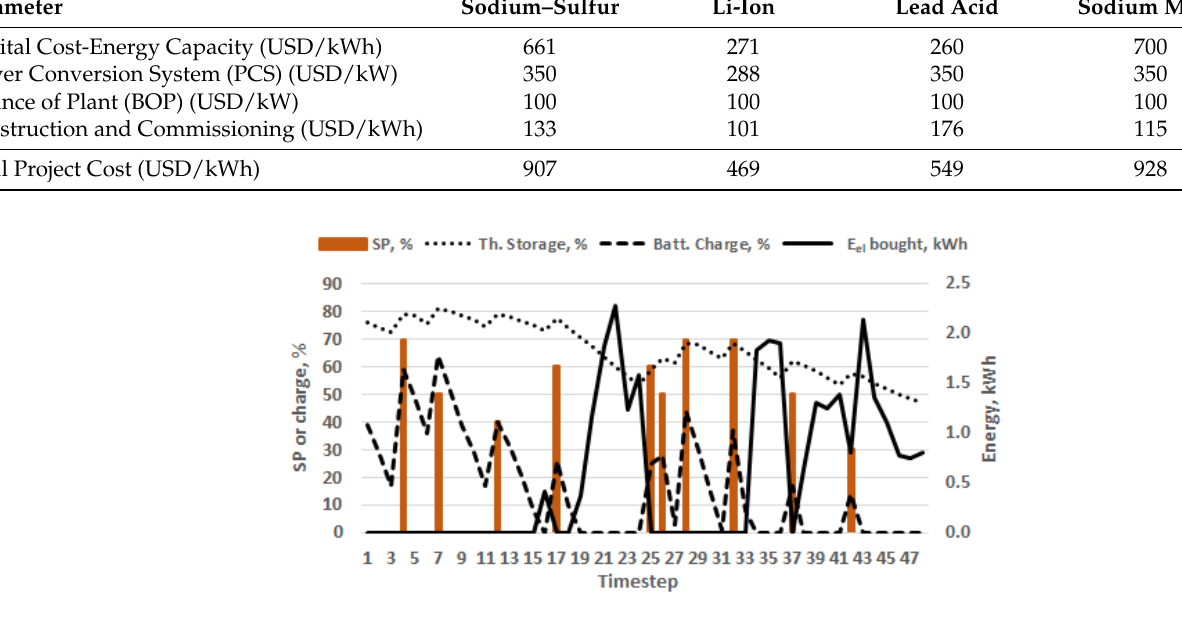
Figure 9. Battery charge/discharge status at every time interval of the operation period. Climate Zone 13, typical day WSB, battery 2 kWh, thermal storage 1200 L, operation